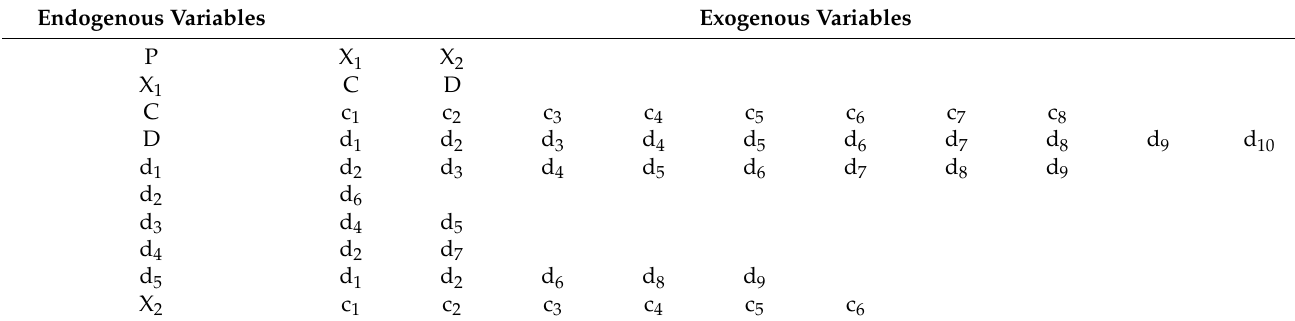
Table 12. The connections between the variables of the model. Endogenous Variables Exogenous